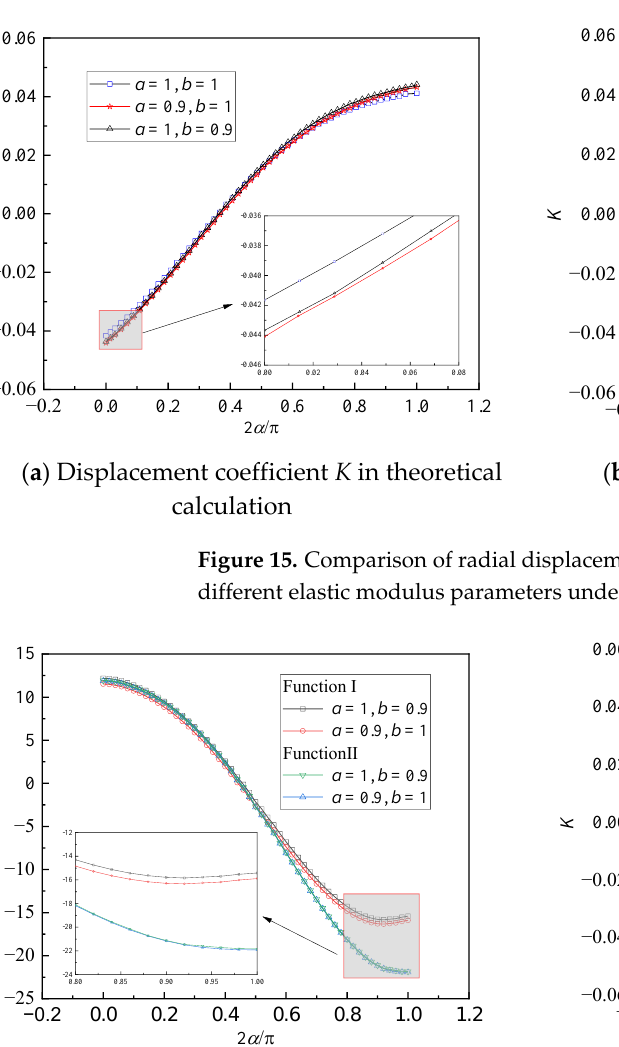
Figure 14. Comparison between the theoretical and numerical results of radial displacement of functionally graded lining under the condition of elastic modulus Function I.